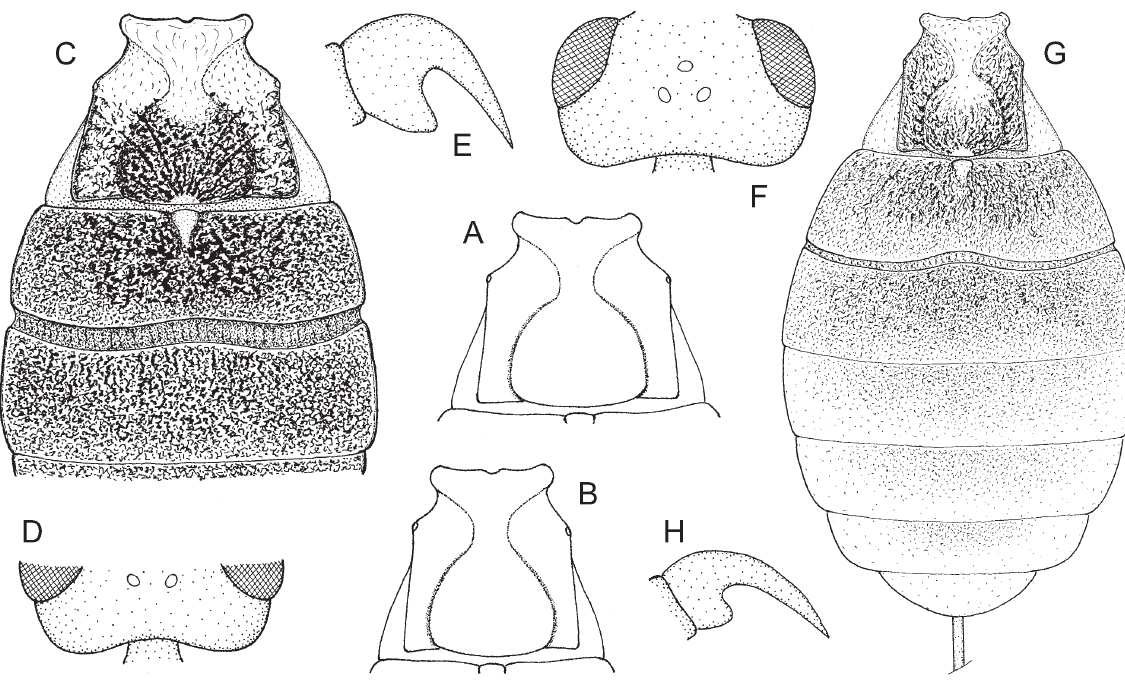
Fig. 46. — A-E. Bracon ( Bracon ) intercessor Nees, 1838 (A-C, E: ♀, D: ♀ / ♂). A-B . First tergite. C . tergites 1-3. D . Hind half of head in dorsal view. E . Claw. — F-H . Bracon ( Bracon ) corruptor Szépligeti, 1901, ♀ holotype. F . Head in dorsal view. G . Metasoma in dorsal view. H .